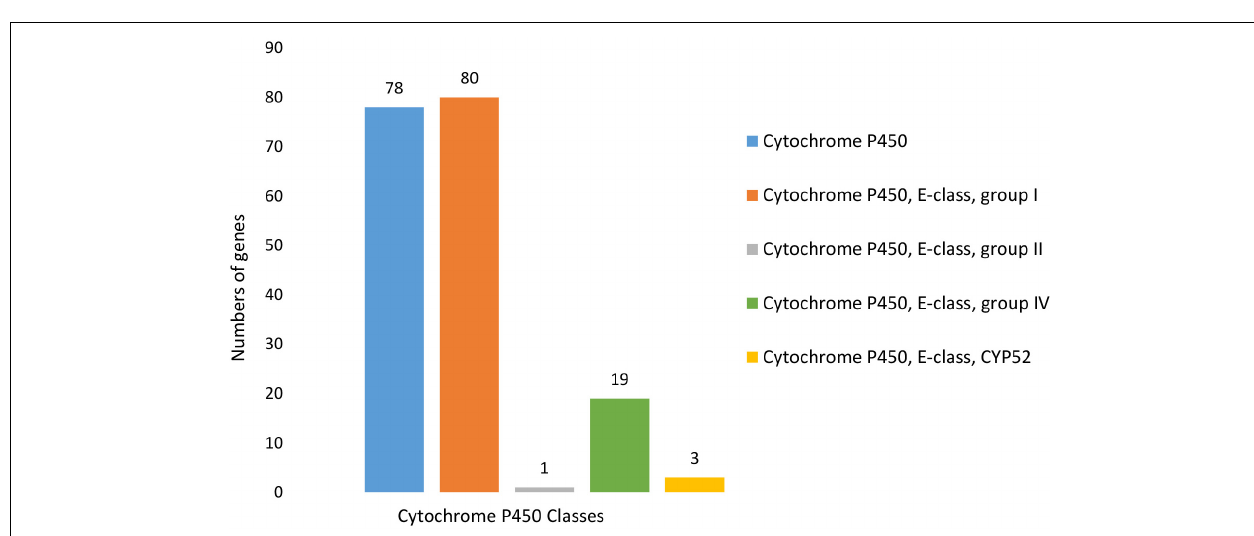
FIGURE 9 | Number and distribution of putative Cytochrome P450 genes identified within the N. psidii genome. Predicted genes were classified according to motif type, which included Cytochrome P450, Cytochrome P450, E-class, group I, Cytochrome P450, E-class, group II, Cytochrome P450, E-class, group IV and Cytochrome P450, E-class,